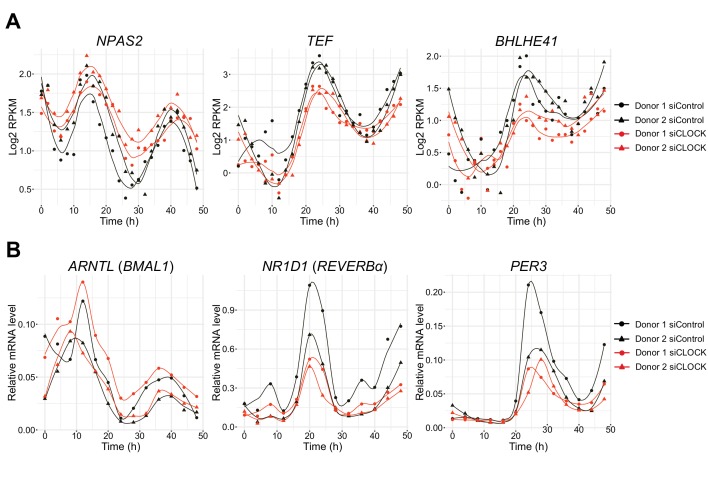
Temporal profiles of core clock transcript expression.(A) Expression profile of NPAS2, TEF and BHLHE41 assessed by RNA-seq. (B) ARNTL (BMAL1), NR1D1 (REVERBα) and PER3 measured by RT-qPCR. mRNA levels were analyzed every 4 hr over 48 hr for each donor to confirm the RNA-seq results. Data were normalized to the mean of 9S and HPRT. For donor one data represent monoplicates, whereas for donor two data were done in duplicates. Donor 1: circle; donor 2: triangle; siControl: black line; siCLOCK: red line.